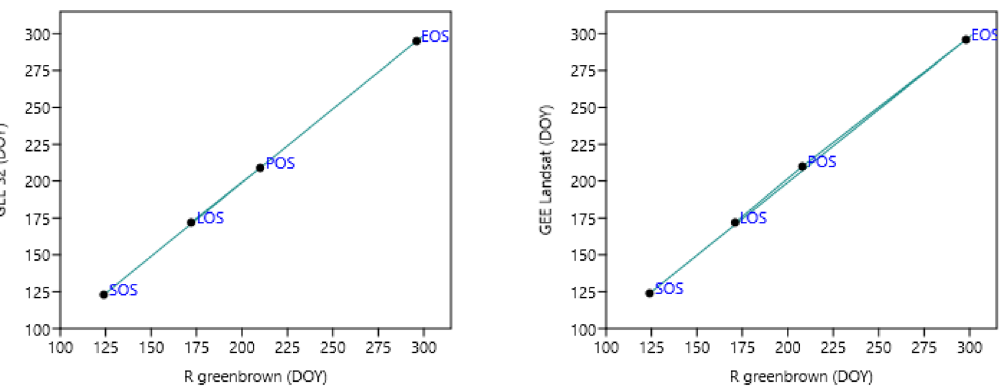
Figure 6. PM comparison, Start of Season (SOS), End of Season (EOS), and Length of Season (LOS) estimated with Sentinel-2 in GEE and MODIS phenology products (ready to use, provided by NASA).